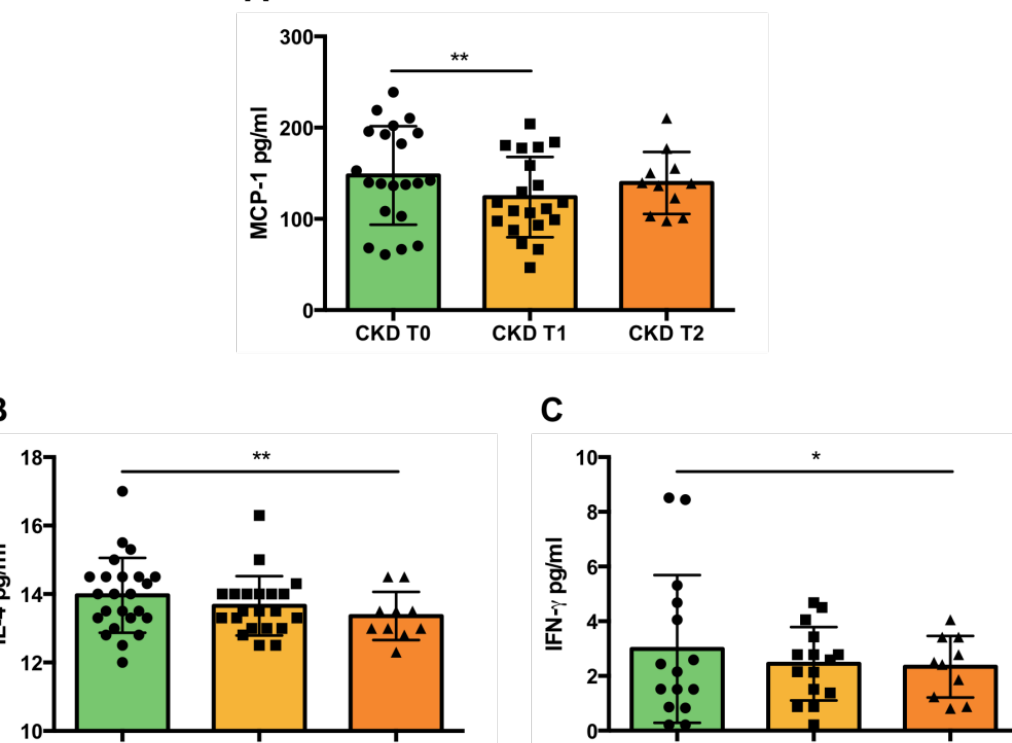
Figure 2. ( A ) Three months curcumin supplementation decreases MCP-1 (CCL-2) plasma levels in CKD patients; ** p < 0.01. ( B,C ) Six months curcumin supplementation decreases IFN- γ and IL -4 plasma levels in CKD patients; * p < 0.05; ** p <